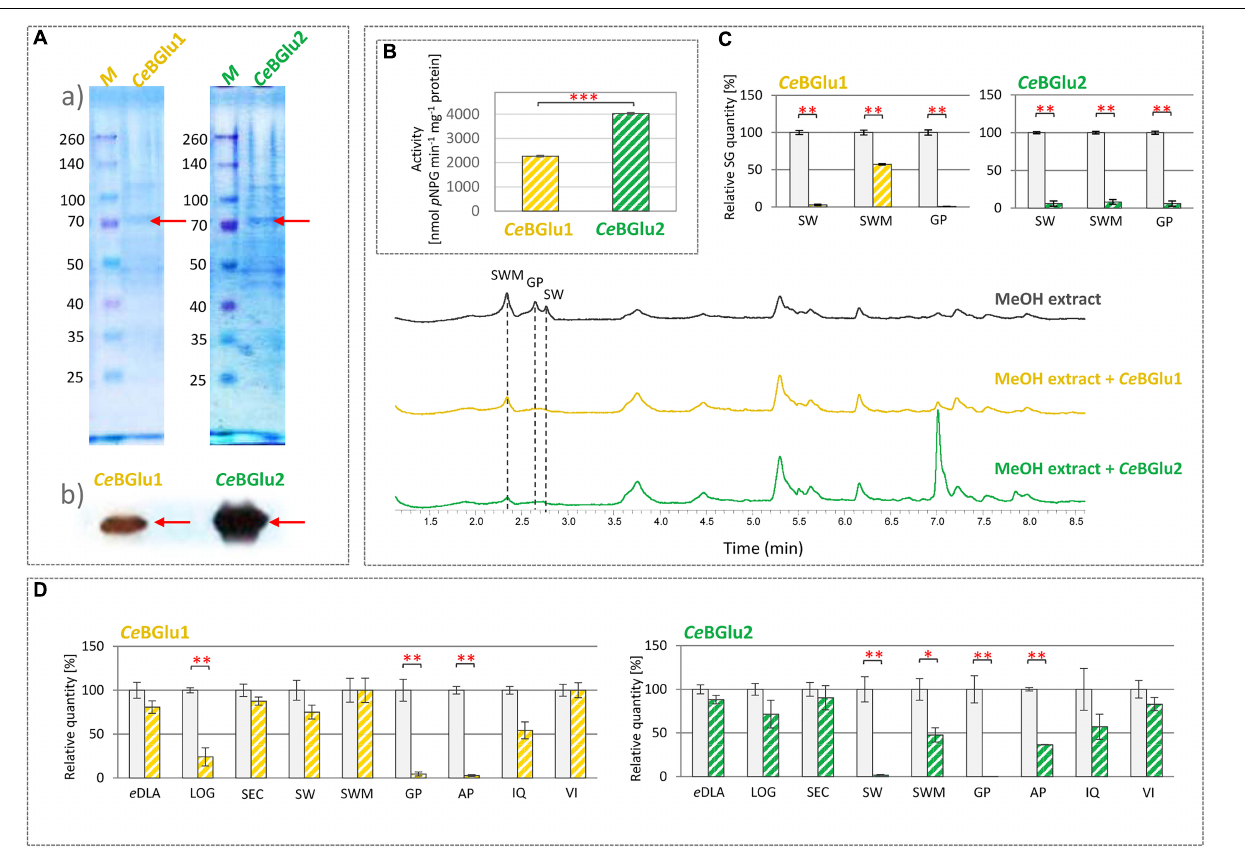
FIGURE 6 | (A) Characterization of recombinant Ce BGlu1 and Ce BGlu2 produced in E. coli BL21: (a) SDS-PAGE electropherogram; M- pre-stained SDS-PAGE size marker; purified recombinant Ce BGlu1 and Ce BGlu2 eluted after His-tag affinity purification, (b) Immunodetection of recombinant Ce BGlu1 and Ce BGlu2 using anti-His antibodies. (B) Hydrolytic activity of recombinant Ce BGlu1 and Ce BGlu2 against synthetic p NPG substrate. (C) Hydrolytic activity of Ce BGlu1 and Ce BGlu2 toward secoiridoids present in methanol extracts of C. erythraea . Presented are representative UHPLC/DAD chromatograms of C. erythraea methanol extracts at λ = 260 nm, before (black line) and after the hydrolysis with Ce BGlu1 (orange line) and Ce BGlu2 (green line). (D) Hydrolytic activity of recombinant Ce BGlu1 and Ce BGlu2 against 1,5,9-epideoxiloganic acid ( e DLA), loganin (LOG), secologanin (SEC), sweroside (SW), swertiamarin (SWM), gentiopicrin (GP), apigetrin (AP), isoquercitrin (IQ), vitexin (VI). The bars indicate the quantity of substrates (%) not enzymatically hydrolyzed in an in vitro enzymatic assay. Control group, where no protein extract was added, was set to 100%, and all the values are presented relatively, in respect to control. Data are mean ± SD ( n = 3). Red asterisks denote significantly different values according to the t- test, p -values, * p < 0.05, ** p < 0.01, *** p < 0.001.